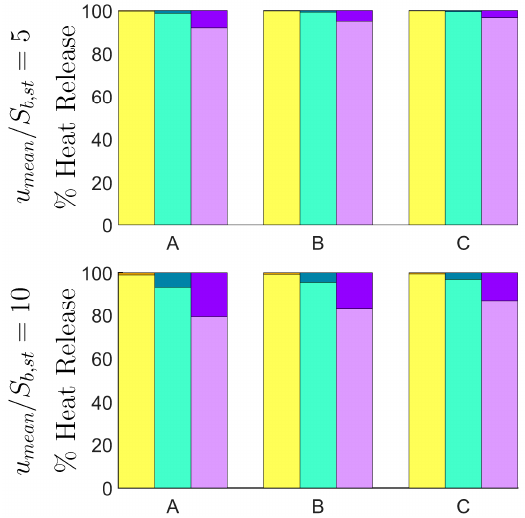
Figure 8. Percentage of heat release arising from premixed (for initial a d / δ st = 0.04 ( ), 0.05 ( ), 0.06 ( )) and non-premixed (for initial a d / δ st = 0.04 ( ), 0.05 ( ), 0.06 ( )) modes of combustion for u mean / S b , st = 5.0 (1st row) and 10.0 (2nd row) at locations A, B and C (left to right).